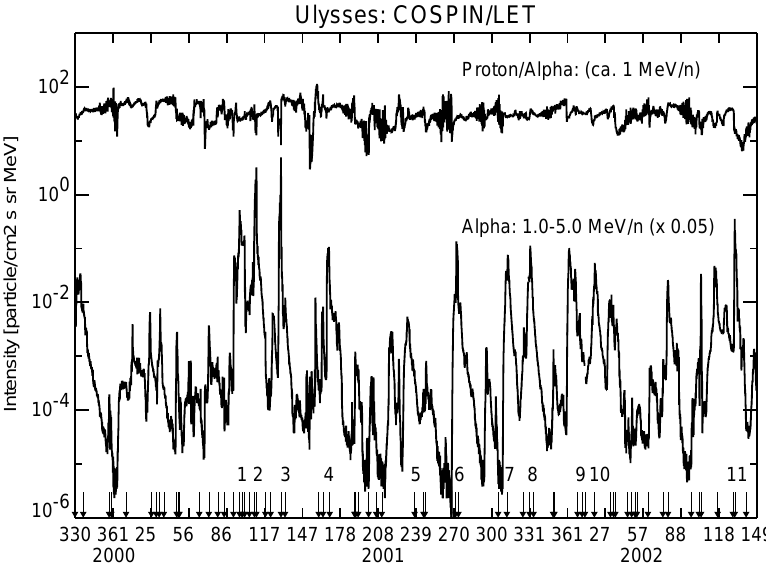
Fig. 2. The 30-min proton (1.2– 3.0 MeV)/alpha(1.0–5.0 MeV/n) and the alpha intensity profiles from DOY 330 in 2000 to DOY 149 in 2002 are 11 represented by solid lines. The ar- rows at the bottom of the panel mark the times of the shock occurrences at